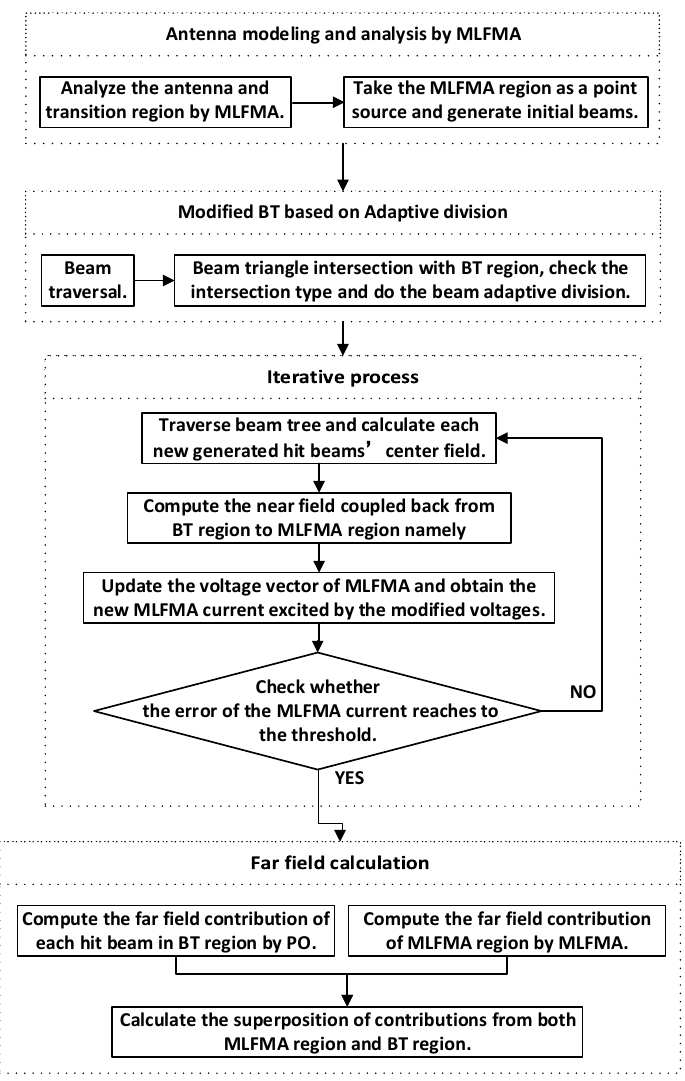
Figure 2. A general flowchart of the iterative MLFMA-MADBT